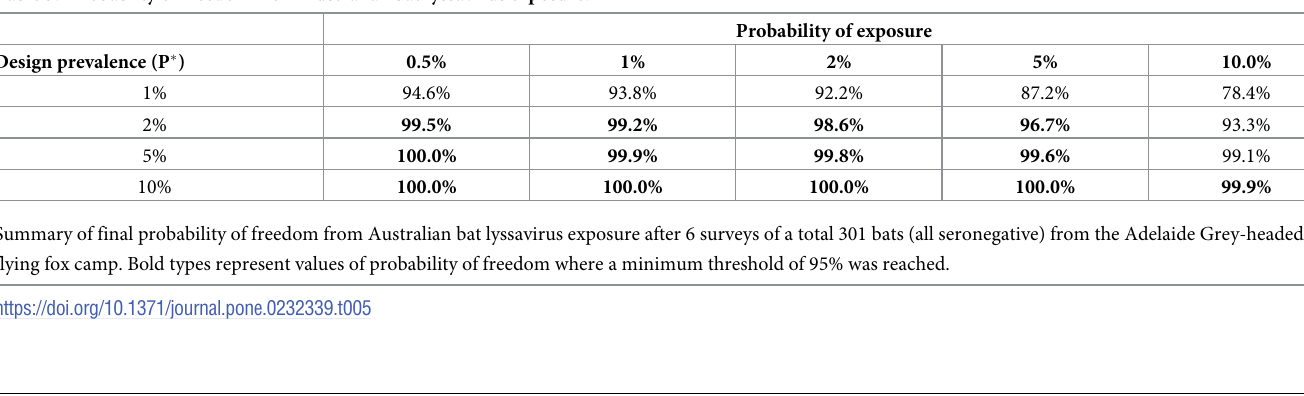
Table 5. Probablity of freedom from Australian bat lyssavirus